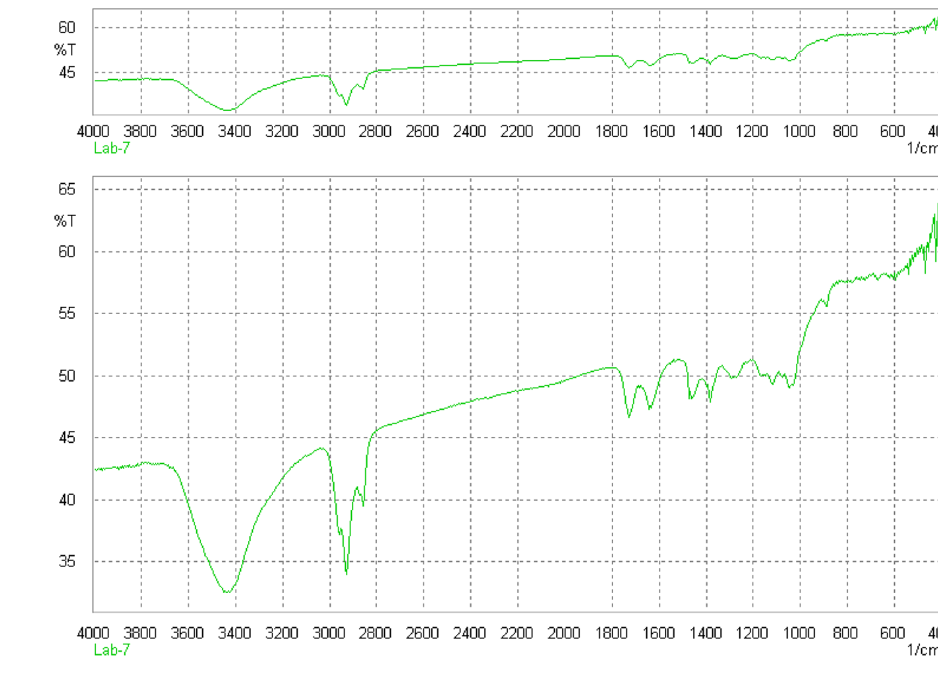
Fig. 3 FTIR spectrum of TLP after adsorption